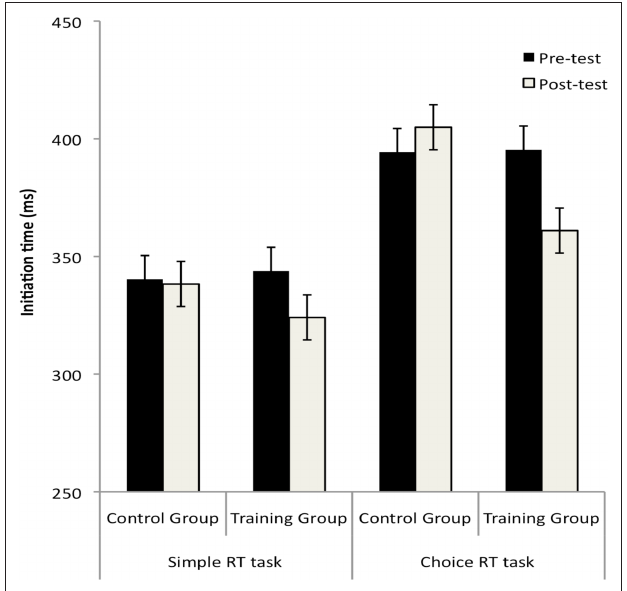
FiGure 3 | mean initiation time (ms) in the simple and the choice reaction time tasks in the control and the training groups (bars represent standard